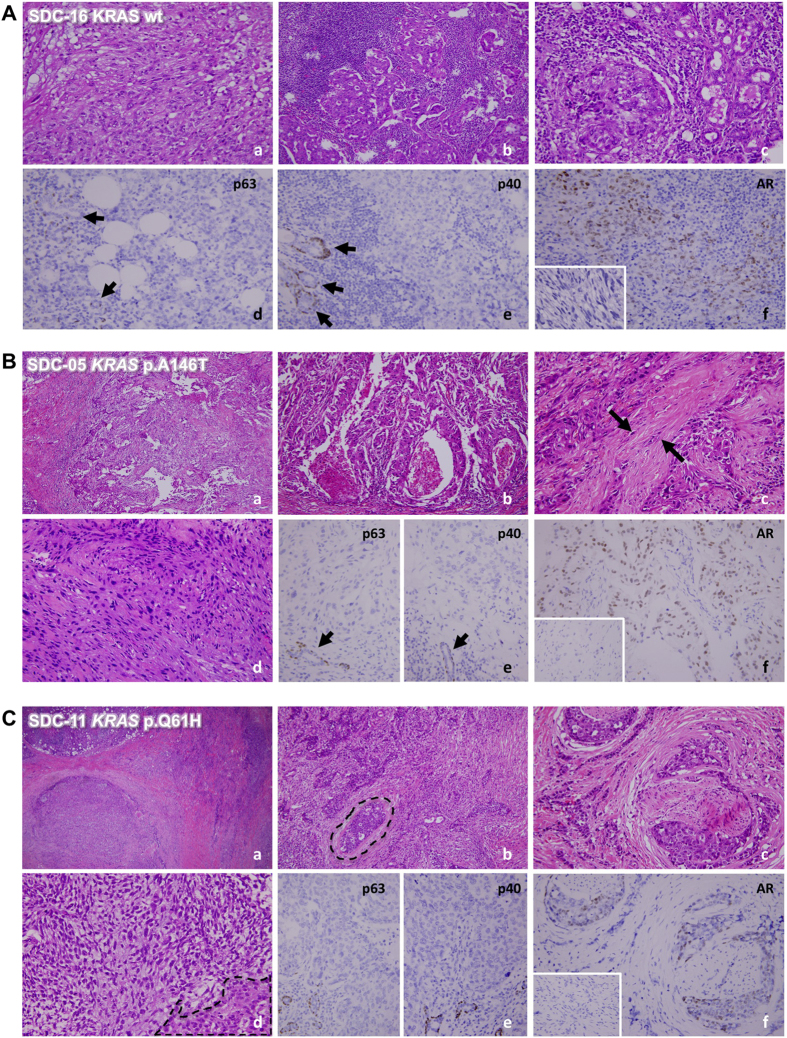
Representative cases of human SDCs.(A) A SDC with co-existence of frank sarcomatous change (a, 200X) and typical SDC morphology (b, 200X). In some of the tumor-adjacent salivary ductules, ductal adenomatoid hyperplasia (c, 200X) can be appreciated with focal transformation to carcinoma in situ-like lesion, suggesting a hyperplasia-dysplasia-carcinoma pathway and further epithelial-mesenchymal transformation in the pathogenesis of SDC. Immunohistochemically, tumor cells are negative for p63 (d, 400X) and p40 (e, 400X). The residual salivary ducts served as internal positive control for p63 or p40 (arrows). Although the tumor cells in conventional SDC area were AR-positive (f, 400X), the sarcomatoid component was AR-negative (inset). (B) A SDC with KRAS p.A146T mutation shows infiltrative growth (a, 100X) by neoplastic glands (b, 200X). Foci of desmoplastic reaction entrapping discohesive spindling tumor cells (c, 200X, arrows) and frank sarcomatous change (d, 400X) are evident. Tumor cells were p63- and p40-negative (e, 400X; arrow depicts p63 or p40 positive control). Although the conventional SDC tumor cells were AR-positive (f, 400X), tumor cells in the sarcomatous area lost AR expression (inset). (C) Another SDC featured by KRAS p.Q61H mutation also demonstrates infiltrating growth (a, 100X) and revealing very focally carcinoma in situ-like area embedded in infiltrating tumor nests (b, dotted line, 200X). Perineurial invasion (c, 200X) and sarcomatous transformation (d, dotted line indicates conventional SDC, 400X) are evident. SDC tumor cells were also negative for p63 and p40 (e, 400X) and positive to AR (f, 400X). Interestingly, as seen in (B), sarcomatous areas lost AR expression.